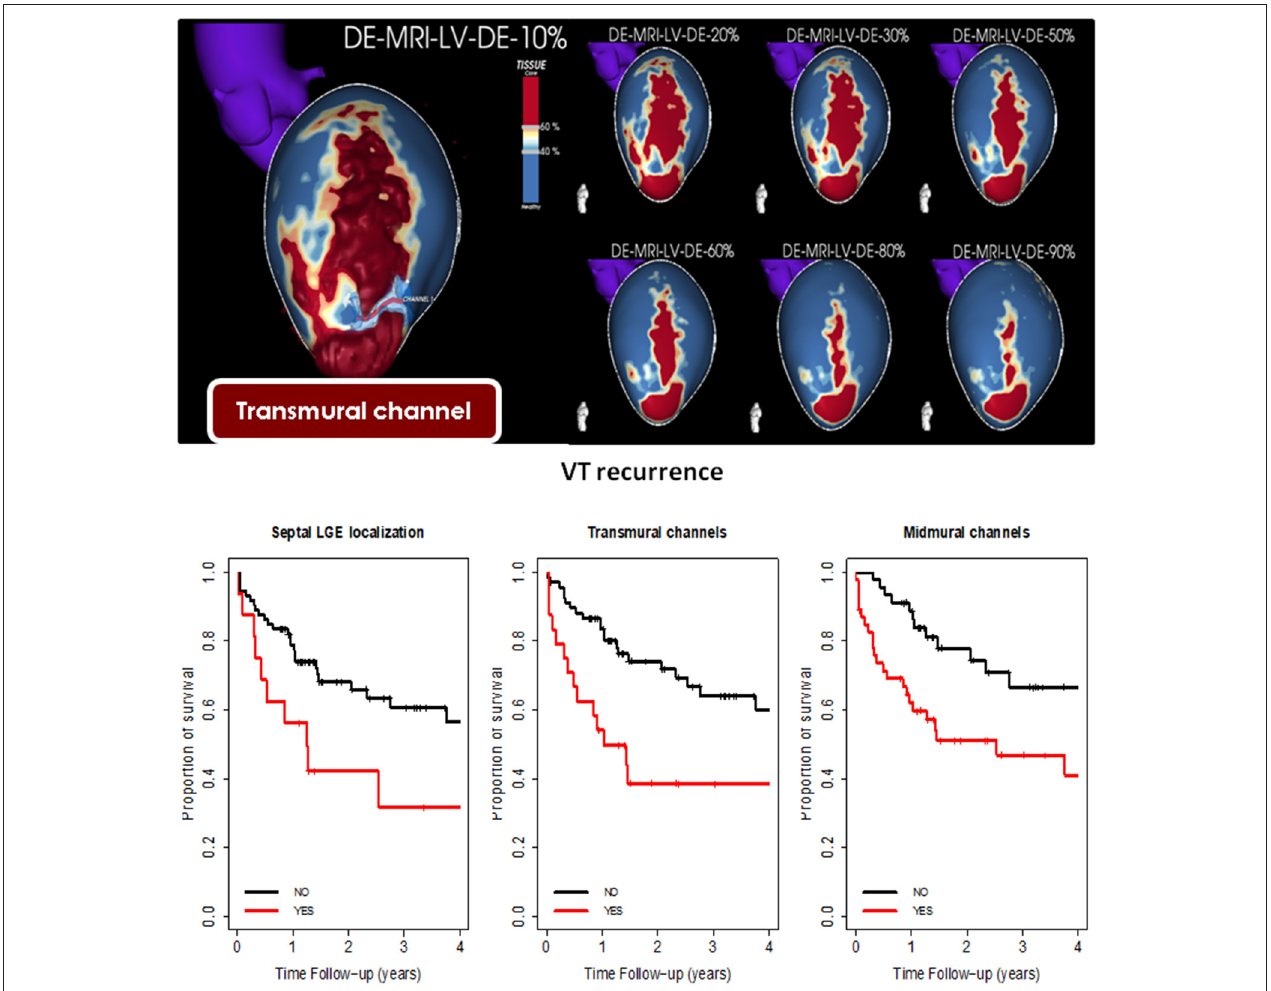
FIGURE 3 | Adapted from Quinto et al. (31). Upper panel: Example of transmural channel in pixel signal intensity (PSI) map of three-dimensional late gadolinium enhancement-cardiac magnetic resonance (LGE-CMR) reconstruction of the left ventricle. The core scar is shown in red, border zone in yellow, and healthy tissue in blue. A clear transmural large anteroapical scar with a channel of border zone in the apical-lateral is seen from the endocardial layers (20–30%) to the epicardial (80–90%). The bottom panel shows the Kaplan-Meier curve for ventricular tachycardia-free survival according to the presence of septal substrate, transmural channels, and midmural